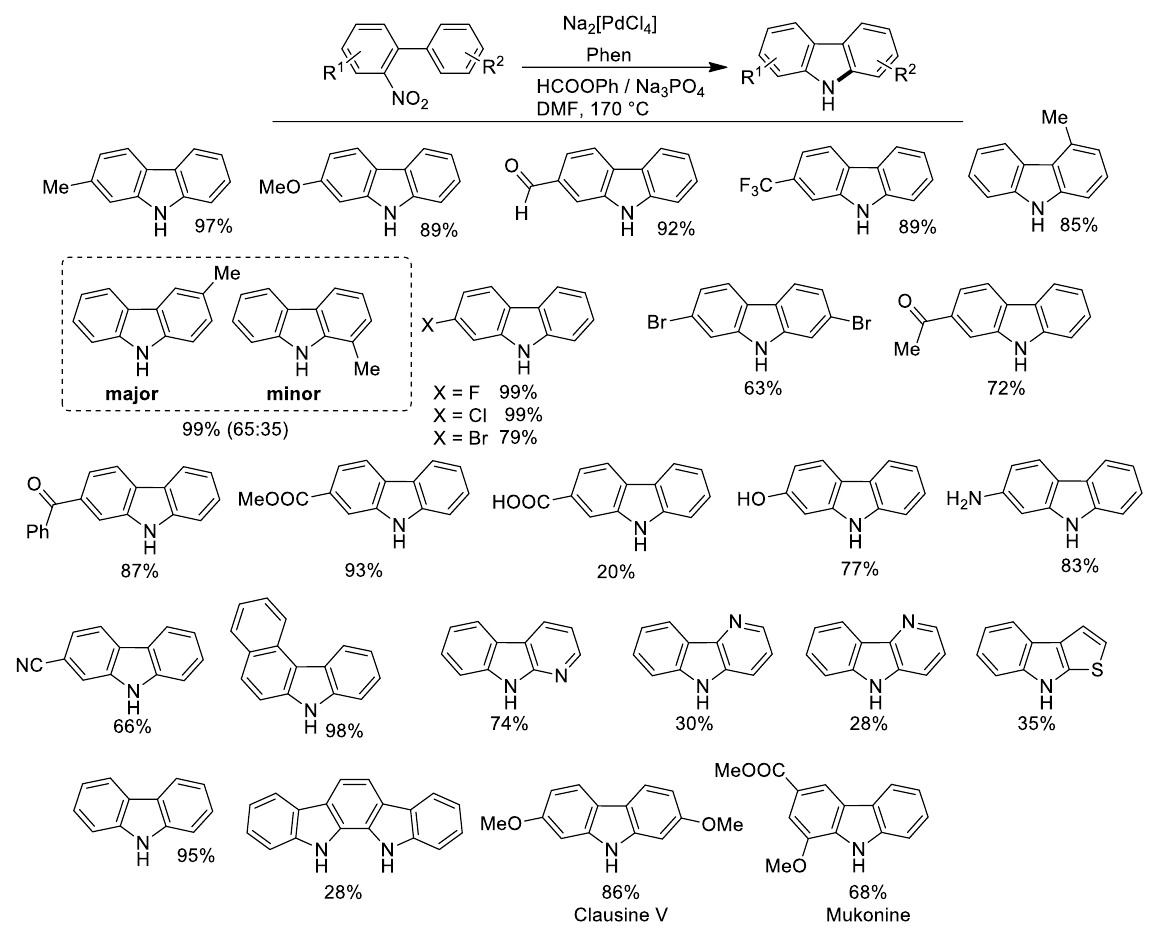
Figure 4. Synthesis of carbazoles from o -nitrobiphenyls. Experimental conditions: nitrobiphenyl (0.54 mmol), Na 2 [PdCl 4 ] 1 mol %, Phen 5 mol %, HCOOPh 2.4 mmol, Na 3 PO 4 7.3 × 10 −2 mmol in DMF (10 mL), at 170 °C for 5 h.